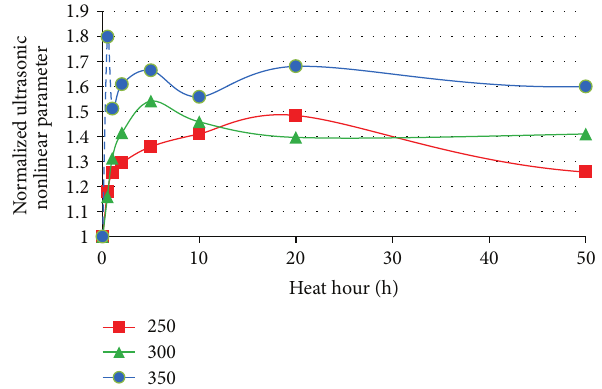
Figure 3: The ultrasonic nonlinear parameter obtained from three heating temperatures (250 ∘ C, 300 ∘ C, and 350 ∘ C), where the data was normalized by the value of ultrasonic nonlinear parameter obtained from no heat-treated